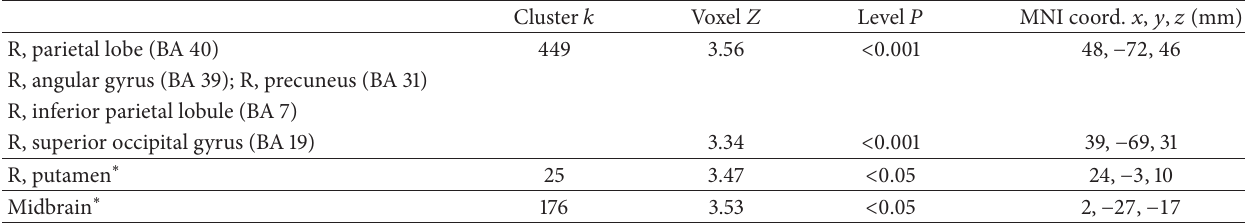
Table 3: Grey matter reduction in PD patients with respect to controls at retest.